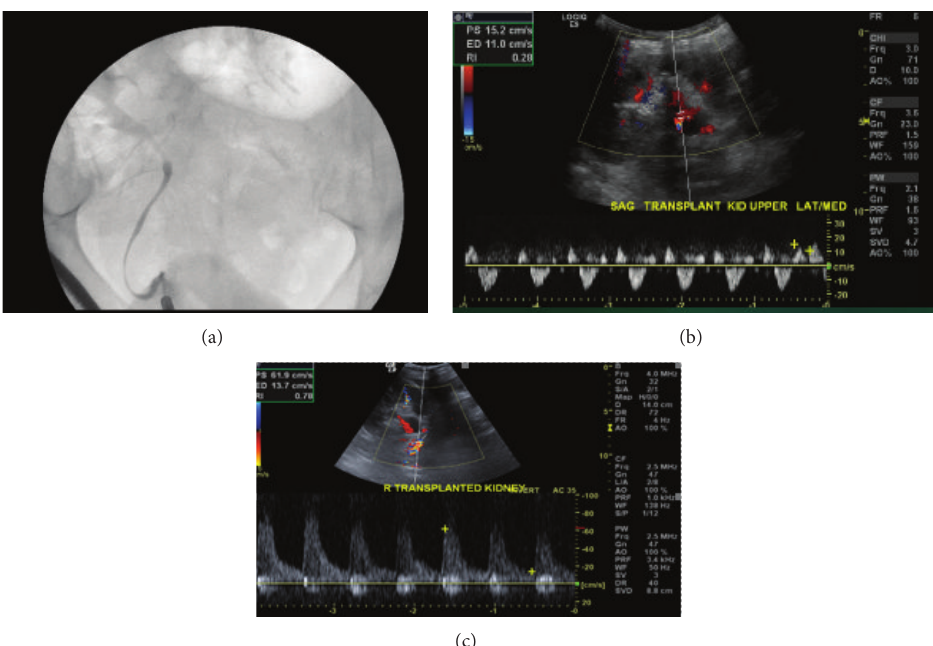
Figure 1: Retrograde pyelography of the kidney allograft showing patency of the ureter, pelvis, and calyces (a). Preprocedural color Doppler of kidney allograft showing renal arterial flow reversal during diastolic phase (b), with normalization of arterial flow pattern on day 1 after the intervention